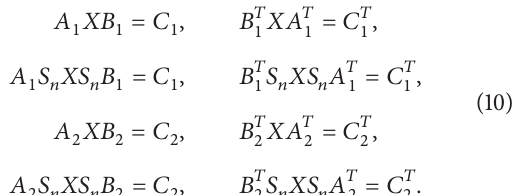
Algorithm 5 (Paige algorithm). (i)